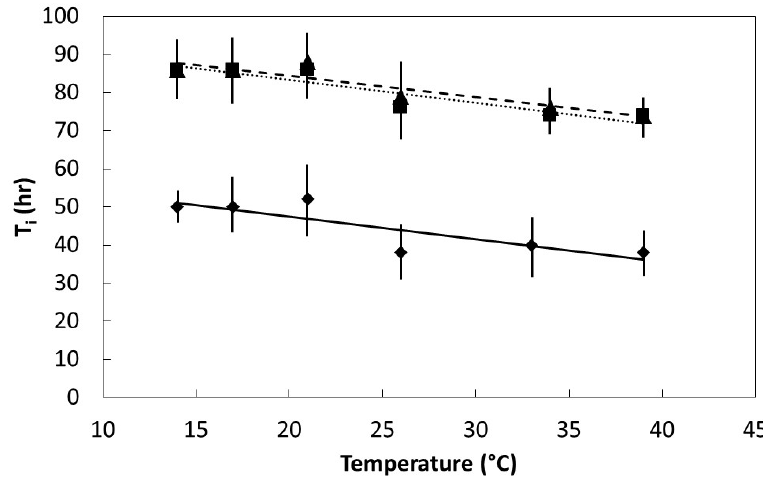
Figure 4. The influence of temperature on initial time of germination for Serianthes species. Mean ± standard error, n = 6. Serianthes grandiflora (squares, dotted line), y = 95.6 − 0.6 x , r 2 = 0.92; Serianthes kanehirae (triangles, dashed line), y = 95.5 − 0.6 x , r 2 = 0.74; Serianthes nelsonii (diamonds, solid line), y = 59.5 − 0.6 x , r 2 = 0.74.